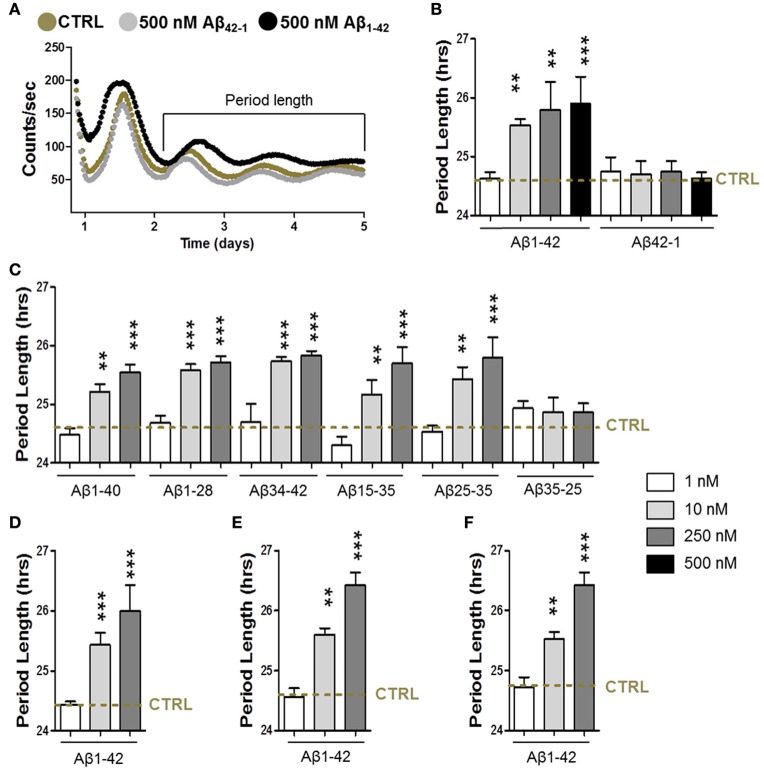
Amyloid-β increases the circadian period length. (A) Representative luminescence records from human skin fibroblasts transfected with mice Bmal1::luciferase reporter in presence of amyloid-β 1–42 (500 nM) or of the reverse peptide amyloid-β 42-1 (500 nM) compared to the condition in the absence of Aβ species (CRTL). (B, C) Circadian period length determined in synchronized human skin fibroblasts transfected with mice Bmal1::luciferase reporter in presence of amyloid-β 1–42 and 42-1 (B), 1–40, 1–24, 34–42, 25–35, 35-25, and 15–25 (C) compared to the condition in the absence of Aβ species (CRTL) (dashed line). (D) Circadian period length determined in synchronized human glioma A172 cells transfected with Bmal1::luciferase reporter in presence of amyloid-β 1–42 compared to control (CRTL) (dashed line). (E) Circadian period length determined in synchronized cortical primary mouse neurons transfected with Bmal1::luciferase reporter in presence of amyloid-β 1–42 compared to control (CRTL) (dashed line). (F) Circadian period length determined in synchronized hippocampal primary mouse neurons transfected with Bmal1::luciferase reporter in presence of amyloid-β 1–42 compared to control (CRTL) (dashed line). Bars represent the mean of at least three independent experiments ± SD. **P < 0.01; ***P < 0.001 for Student's two-tailed t-test, compared to control.